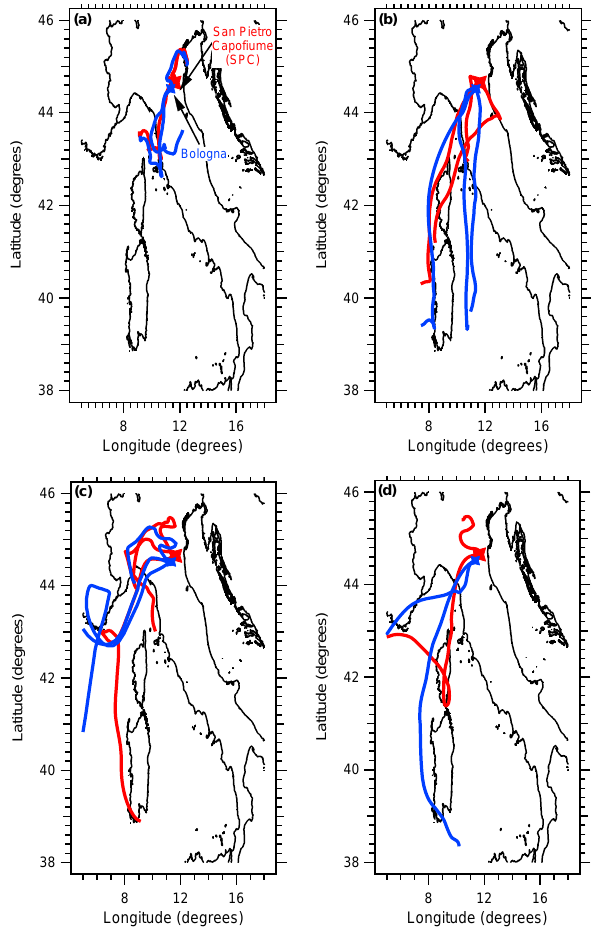
Figure 2. Characteristic 72h air mass back trajectories for (a) Pe- riod A, (b) Period B, (c) Period C, and (d) Period D at the PE- GASOS ground sites of Bologna and SPC. All back trajectories are based on the NOAA ARL HYSPLIT trajectory